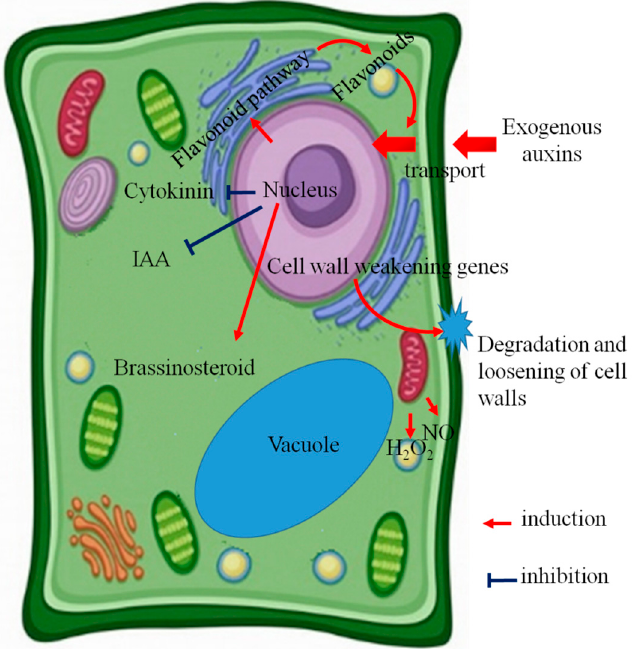
Figure 1. The potential mechanisms involved in auxin-induced adventitious root formation in tea cuttings. H 2 O 2 , hydrogen peroxide; IAA, indole-3-acetic acid; NO, nitric oxide. Authors Contribution: